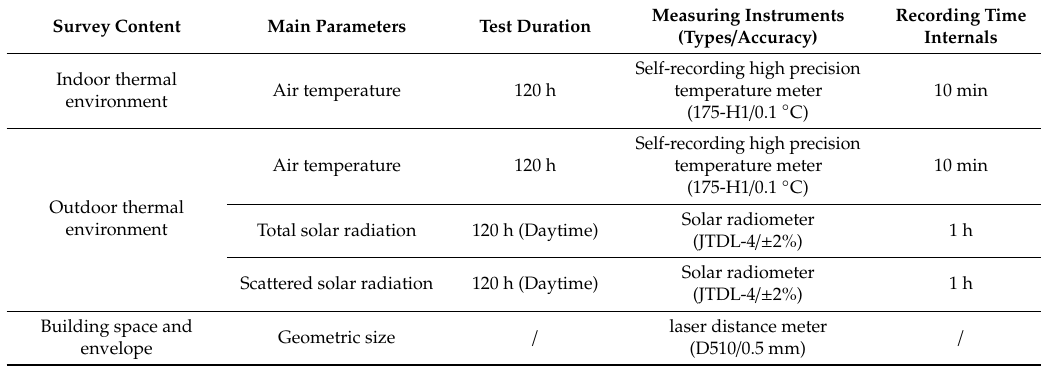
Table 1. Main information about the testing.